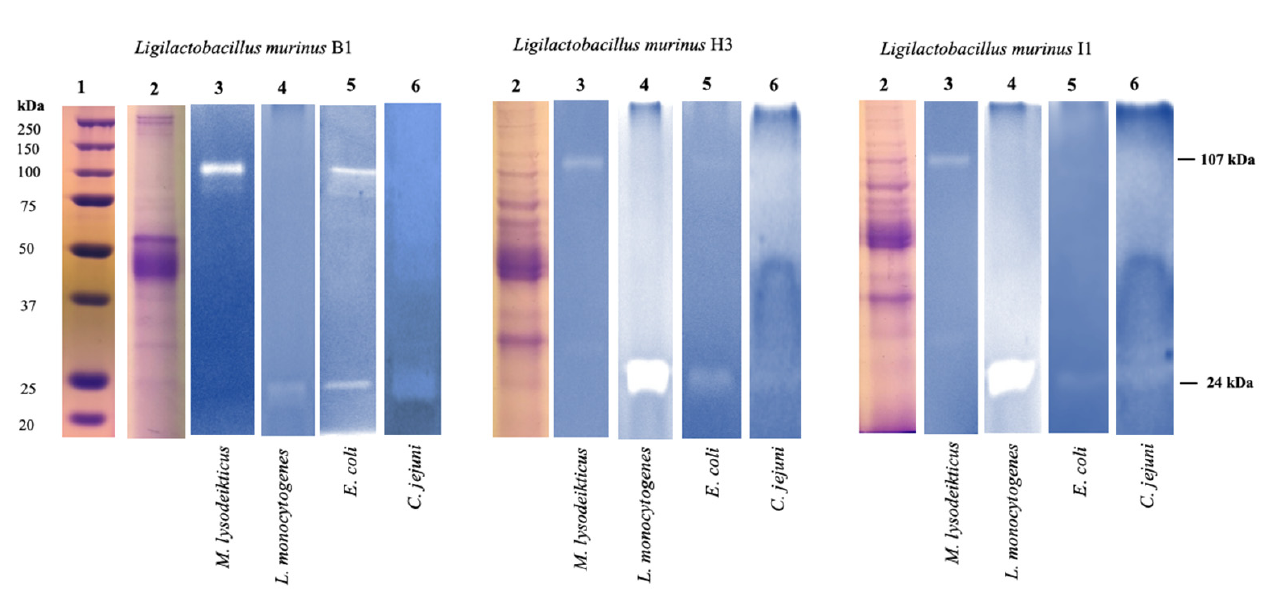
Figure 2. SDS-PAGE, 12%, and Zymograms. Line 1 Molecular Weight Marker, Precision Plus Protein TM All Blue, Bio-Rad. Line 2 Protein profile of culture supernatant in logarithmic phase. Zymograms copolymerized with Line 3 Micrococcus lysodeikticus , Line 4 Listeria monocytogenes , Line 5 Escherichia coli REPEC, and Line 6 Campylobacter jejuni .